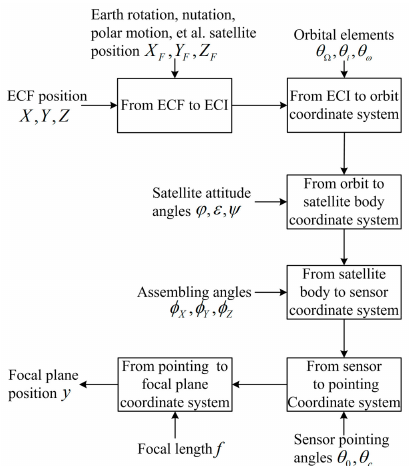
Figure 1. Basic flow diagram of the imaging process for the linear array push-broom